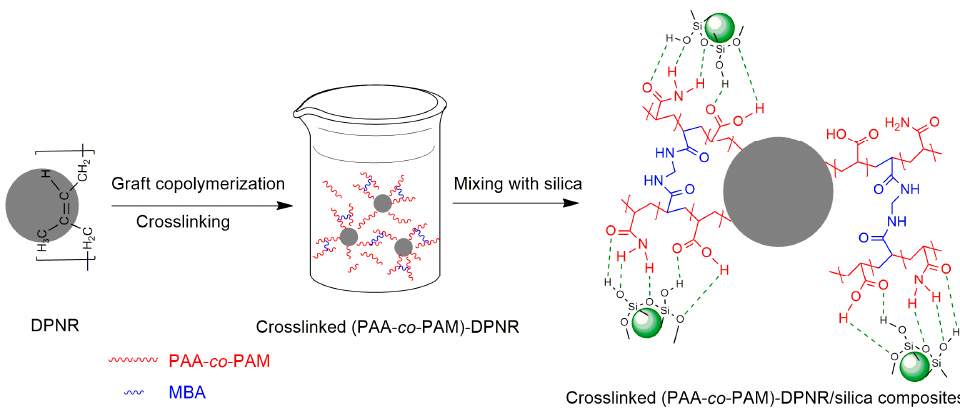
Figure 4. Schematic representation of the fabrication of the crosslinked (PAA-co-PAM)-DPNR/silica